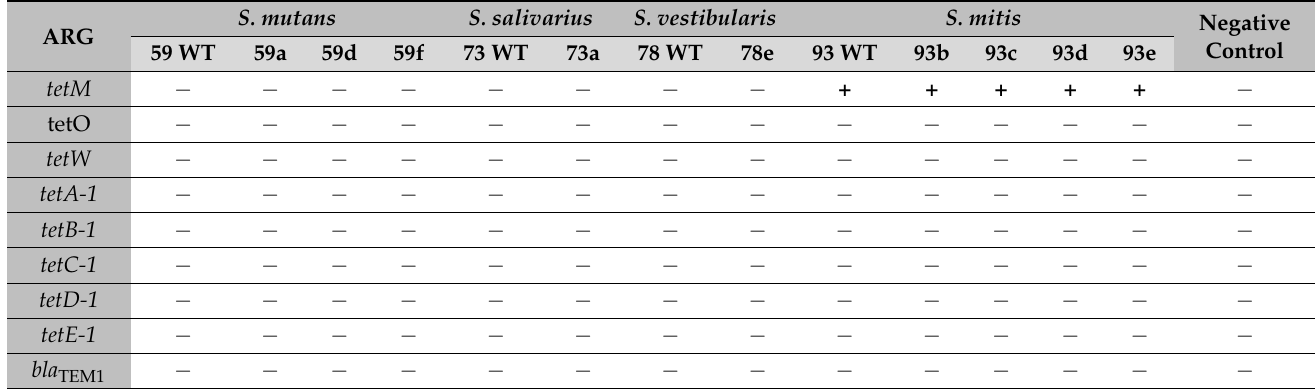
Table 5. Antibiotic resistance genes (ARGs) of P10 replicates showing 8-fold MIC increase toward CHX and corresponding WT strains as detected by